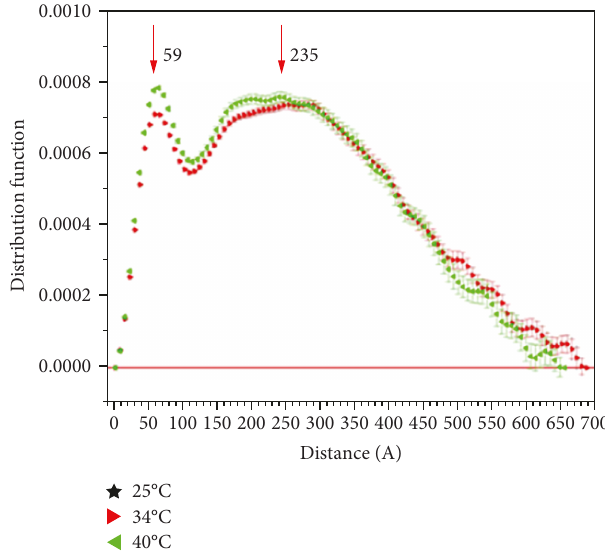
Figure 5: Distance distribution functions of D-g-PNIPAM/AgNP nanosystems at di ff erent temperatures: 25 ° C (black curve), 32 ° C (red curve), and 40 ° C (green curve).